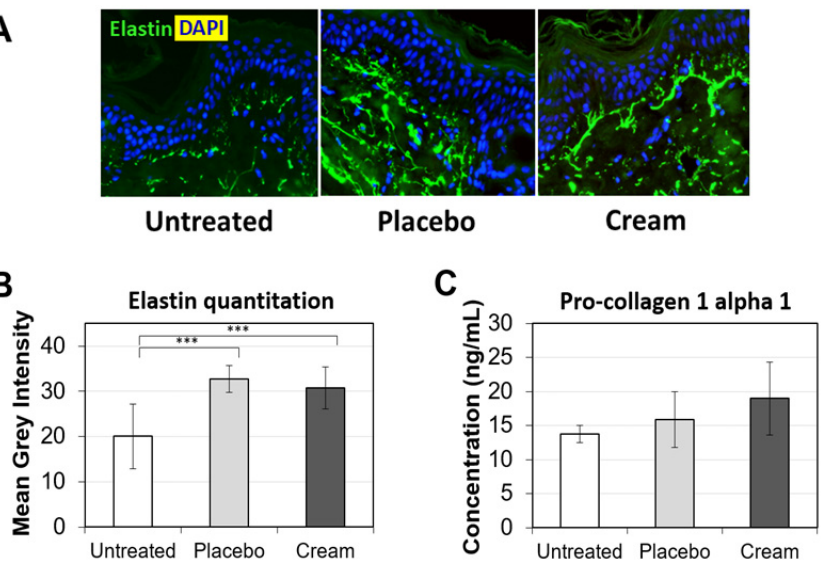
Figure 5. Evaluation of the ECM on human skin explants after eight days of topical treatment. ( A ) Representative images of skin sections of the untreated, placebo (negative control formulation), and cream (test product) groups stained for elastin (green) by immunofluorescence. The nucleus (DAPI) is counterstained in blue. ( B ) Elastin expression is quantitated by image processing and analysis of n = 5 samples. ( C ) Pro-collagen 1 alpha 1 protein expression was measured by ELISA. The data presented are the mean ± SEM. Statistical comparison of the mean values was achieved using a t-test (*** p < 0.001).